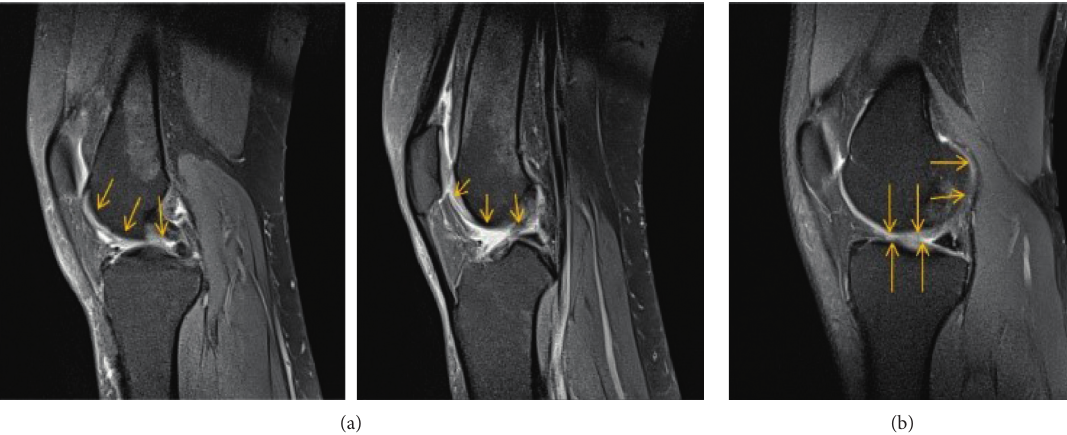
Figure 2: (a) Irregular cartilage tissue. (b) Diffused edges between the tibia and femur bone.